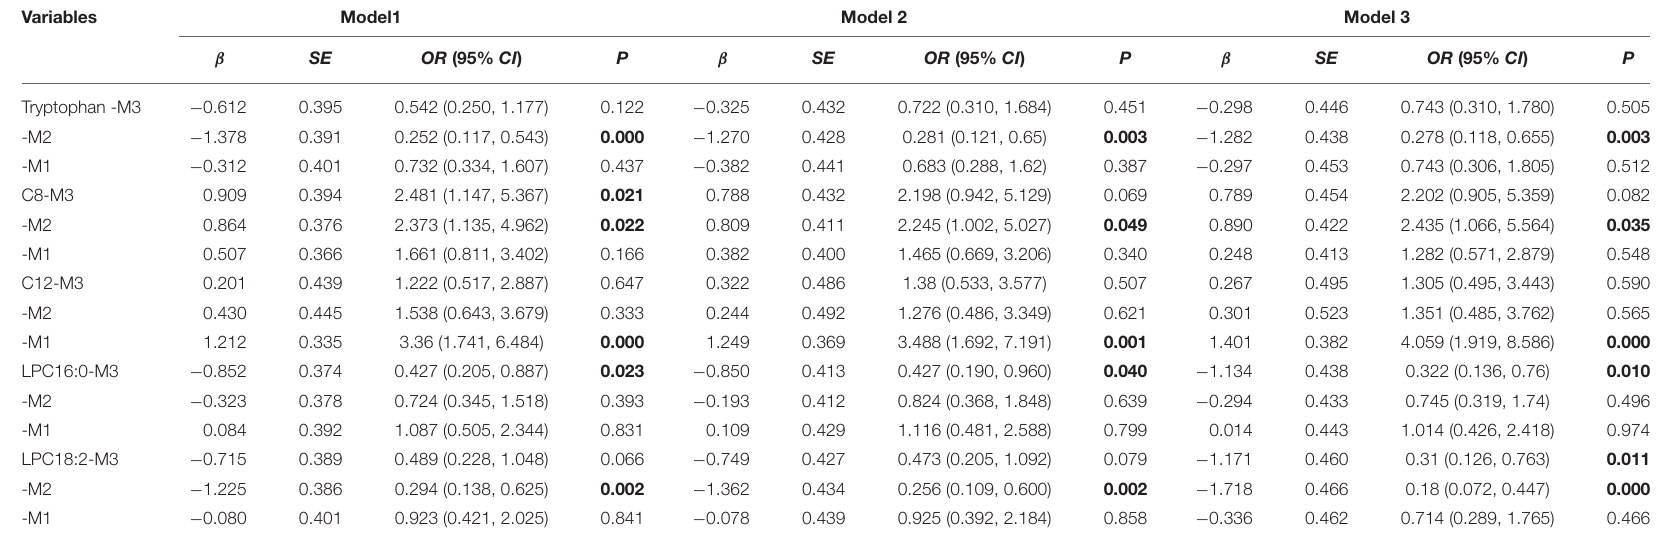
TABLE 3 | Logistic regression analysis for significant associations of serum metabolites with